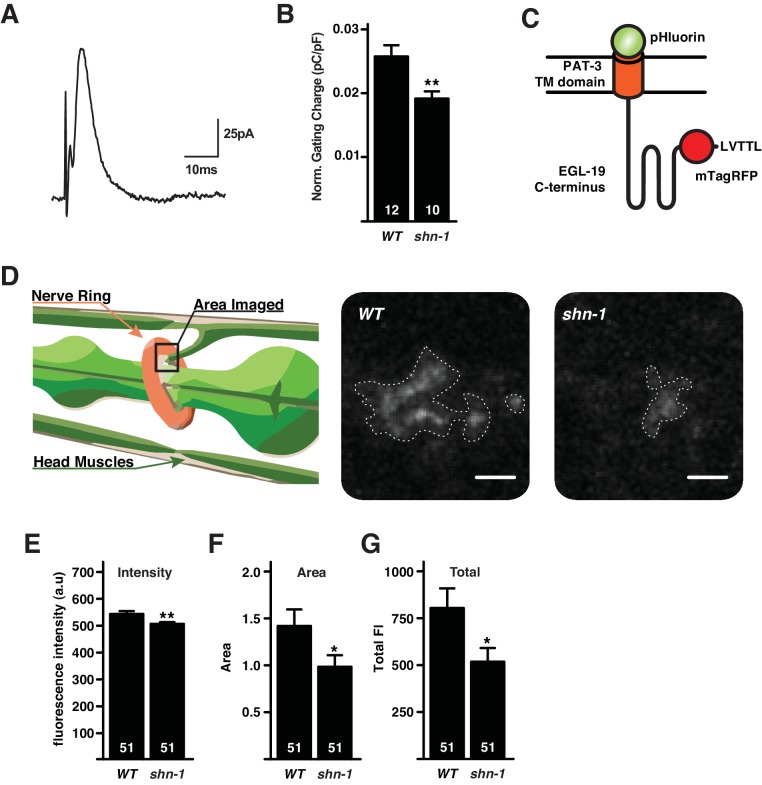
SHN-1 promotes EGL-19/Cav1 delivery to the cell surface.(A–B) Voltage-activating gating currents were significantly decreased in shn-1 null mutants. Averaged trace of gating current in wild type adult body muscles (A) and mean gating charge (normalized to capacitance) (B) are shown. (C–G) Surface delivery of the Terrier fusion protein is significantly reduced in shn-1 null mutants. (C) A schematic illustrating the structure of the Terrier fusion protein is shown. (D) A schematic illustrating the imaged region (left) and representative images of Terrier pHluorin fluorescence in the nerve ring are shown. Mean pHluorin puncta intensity (E), pHluorin puncta area (F), and total pHluorin puncta fluorescence (G) are shown. Regions of interest utilized to quantify Terrier fluorescence are indicated (D). The number of animals analyzed is indicated for each genotype. Values that differ significantly from wild type controls are indicated (**p<0.01, *p<0.05). Error bars indicate SEM.